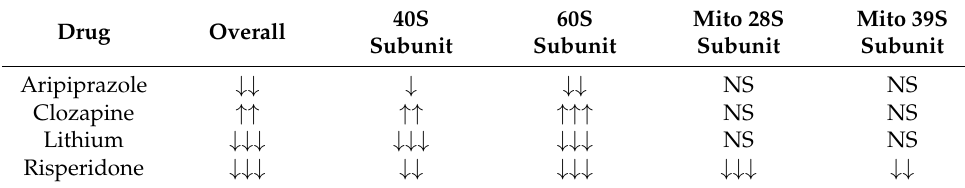
Table 2. Overview of the transcriptional regulation of components of the ribosome by psychotropic drugs. The direction of the arrow represents the direction of regulation ( ↑ up- or ↓ down-regulation) following drug treatment and the number of arrows represents the magnitude of p -value ( ↑ or ↓ = less than 0.05; ↑↑ or ↓↓ = less than 0.01; ↑↑↑ or ↓↓↓ = less than 0.001; NS = No significant difference).